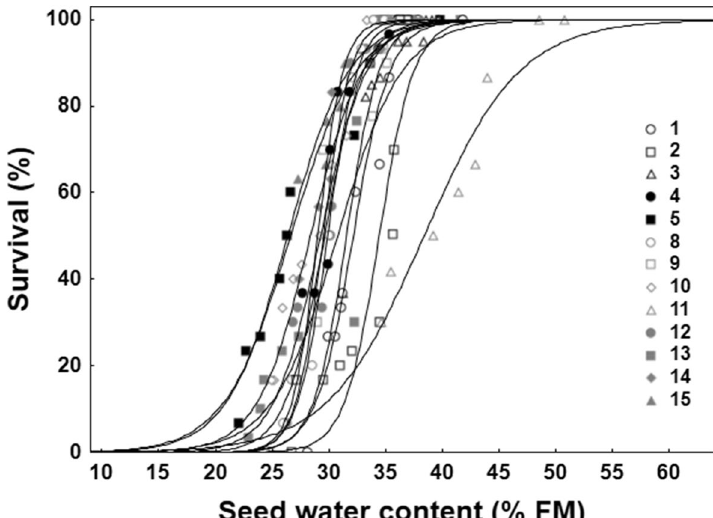
Fig. 5 Survival of seeds of the different Quercus ilex populations studied after desiccation to various water contents. Viability was estimated as the percentage of